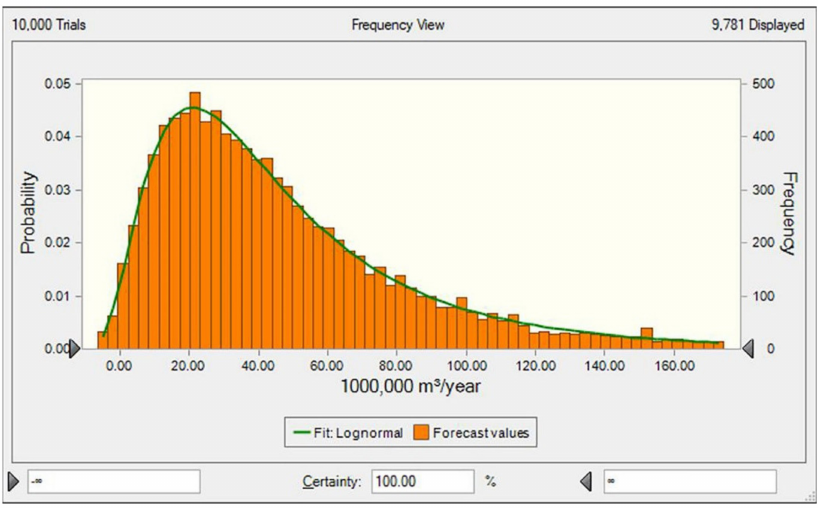
Figure 2. Probability distribution of the water resources in the Nenjiang